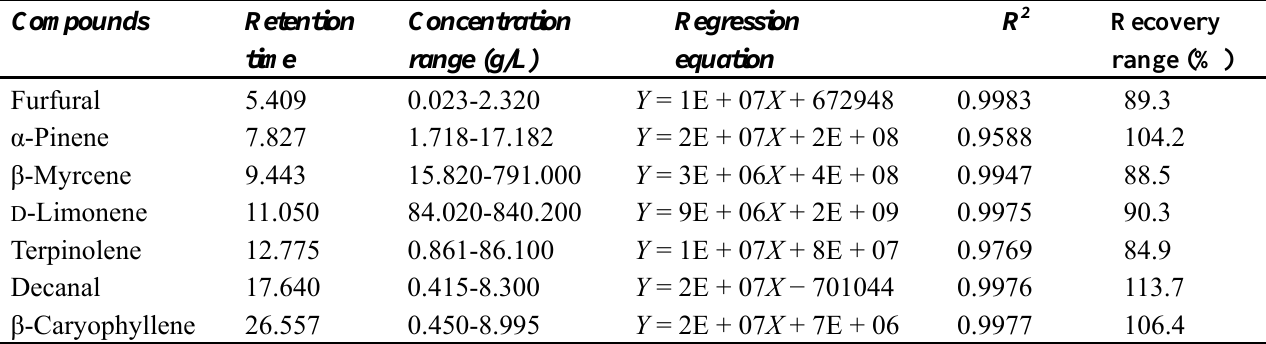
Table 2. The concentration range, regression equations, R 2 , recovery for the standard